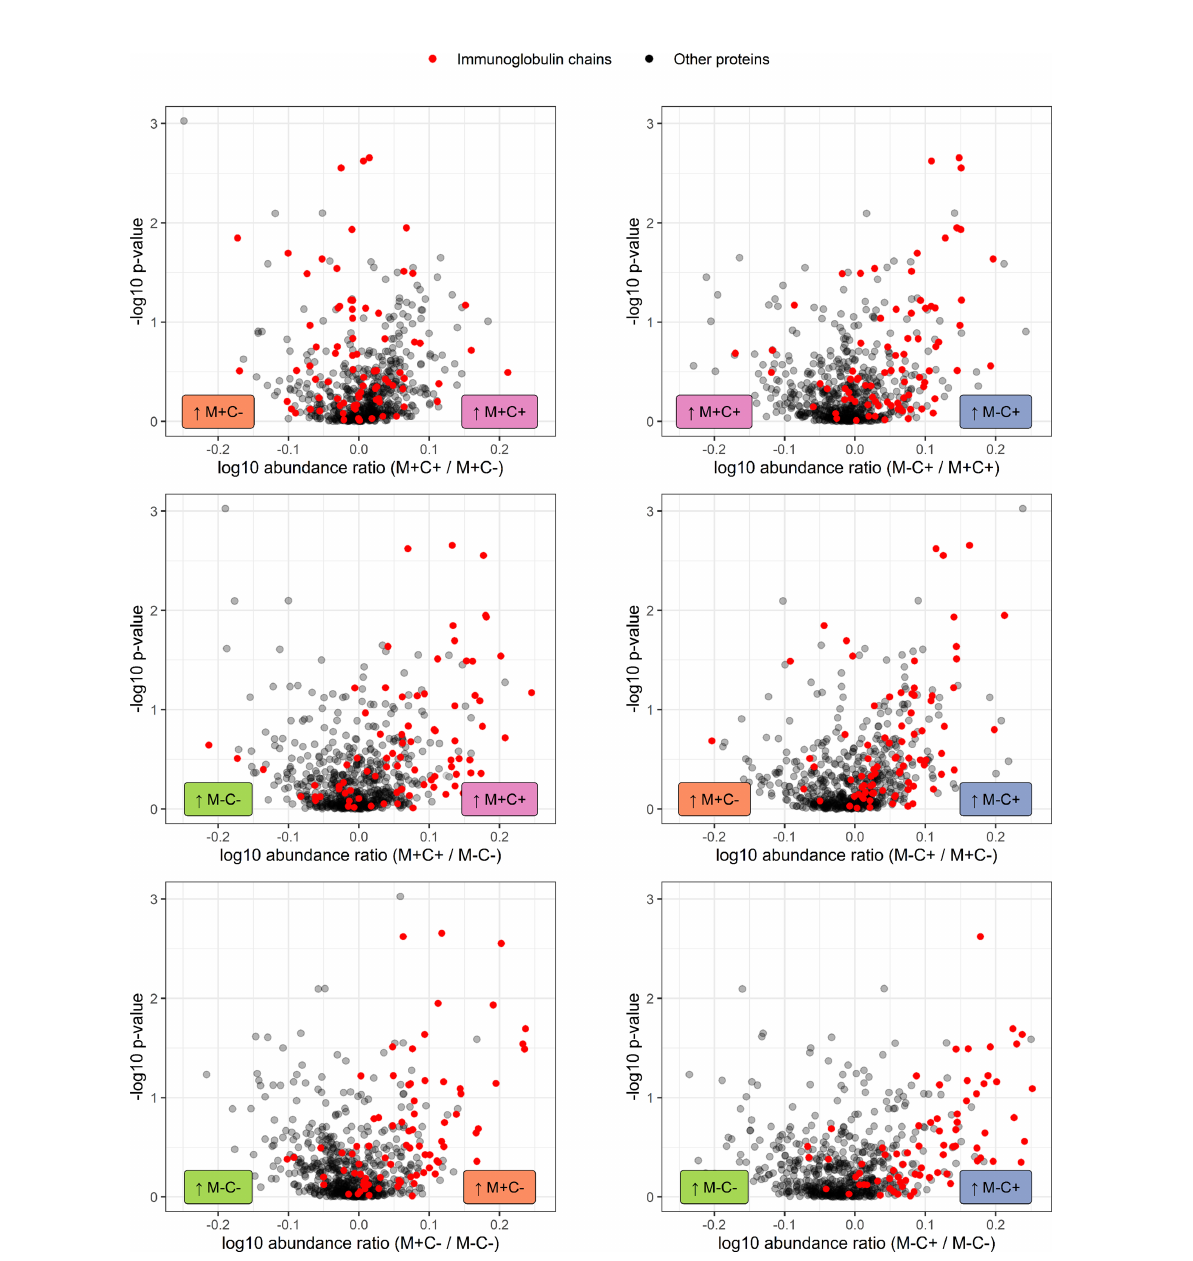
FIGURE 4 Volcano plots visualizing the trend in immunoglobulin abundances in milk from different mother-child allergy status groups from the CHILD Cohort Study. Each data point represents one protein, with on the x-axes the ratio of the means of the log10 transformed label-free quanti fi cation (LFQ). Immunoglobulin-related proteins are represented by red and other proteins with grey dots. Colored labels on left and right side of x = 0 indicate in which mother-child allergy status group the mean abundance of the respective proteins is higher. In the labeling of the groups, M indicates mother, C indicates child, + indicates allergy, and - indicates no allergy. A trend can be observed that most immunoglobulin-related proteins are higher in abundance in the group where the mother is non-allergic and the child ultimately develops an